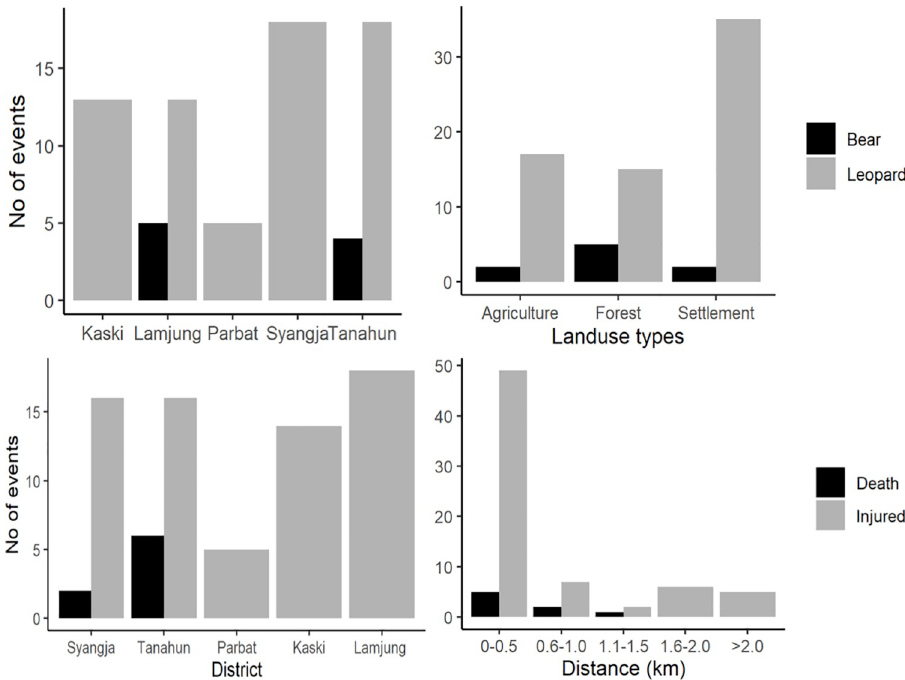
Fig 4. Spatial distribution of HWCs in PLSTK districts during 2011 to 2019 showing events by districts, land use type and distance of the event site from the forest.